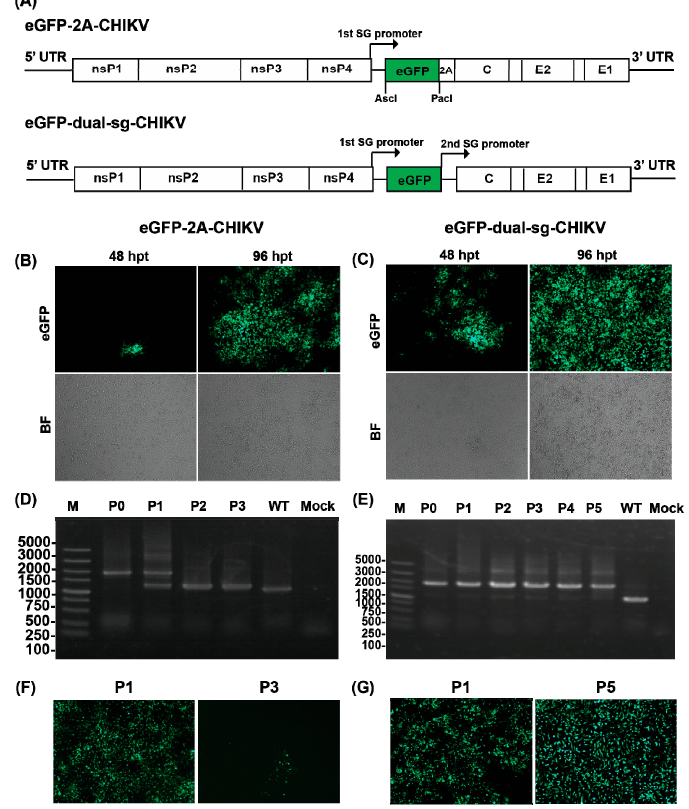
Figure 3. Construction and stability of CHIKV reporter viruses. ( a ) schematic of the construction of two versions of CHIKV reporter virus (eGFP-2A-CHIKV and eGFP-dual-sg-CHIKV). An infectious cDNA clone of pACYC-CHIKV was used as a backbone for the construction of CHIKV reporter viruses; ( b , c ) eGFP expressions in cells transfected with different versions of CHIKV reporter RNA transcripts. The data for eGFP-2A-CHIKV and eGFP-dual-sg-CHIKV were present on left and right panels, respectively, and thereafter. The expression of eGFP in transfected BHK-21 cells was analyzed by fluorescent microscopy at the indicated time points post-transfection. The lower panels were the images visualized under differential interference contrast microscopy; ( d , e ) detection of the eGFP gene during virus passage. Viral RNAs were extracted from culture supernatants of the indicated passages, respectively. RT–PCR was performed with primer pairs to cover the complete eGFP gene region. The resulting RT–PCR products were resolved by 1% agarose gel electrophoresis; and ( f , g ) detection of eGFP expression in BHK-21 cells infected with different passages of reporter viruses. eGFP expressions were observed under fluorescent microscope at 48 hpi. Both RT-PCR and eGFP expression results indicated that the reporter gene still maintained in eGFP-dual-sg-CHIKV. The eGFP-dual-sg-CHIKV was designated as eGFP-CHIKV.